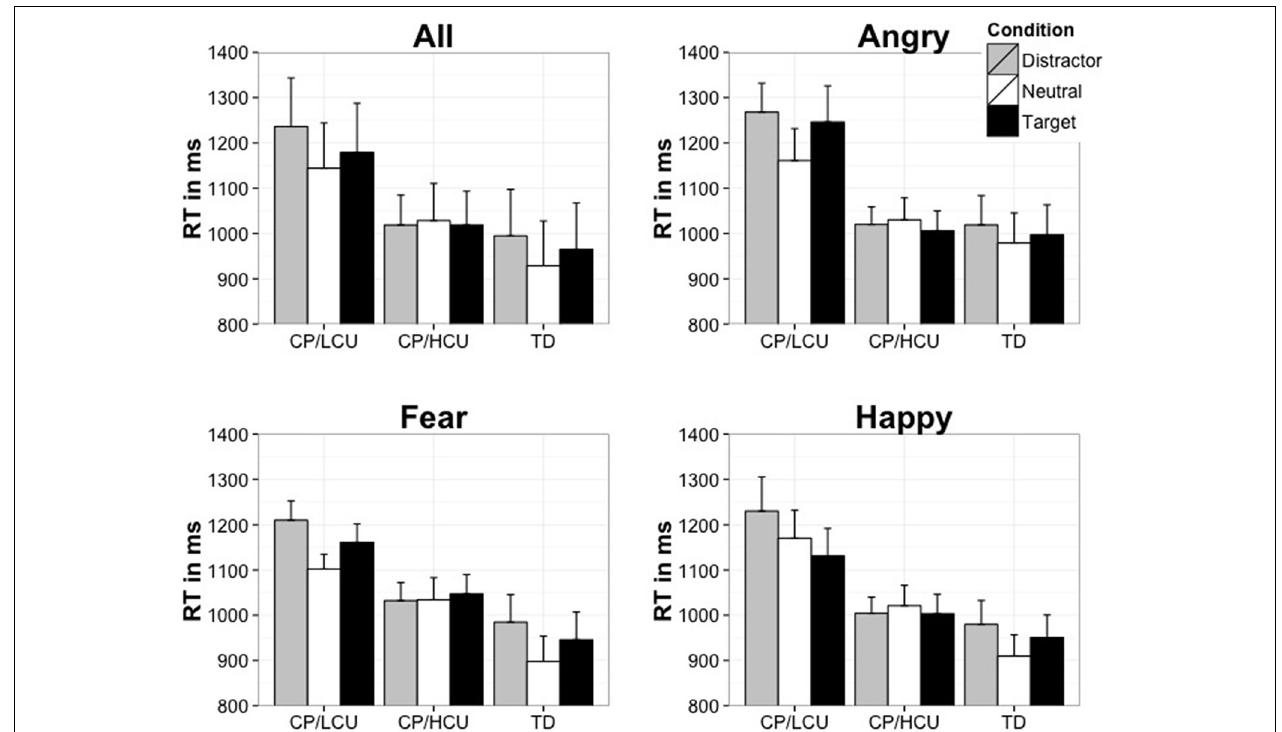
FIGURE 2 | Mean time (in msec) to locate the target face in the presence of an emotional face (either as a target or non-target). NB: error bars show standard error.